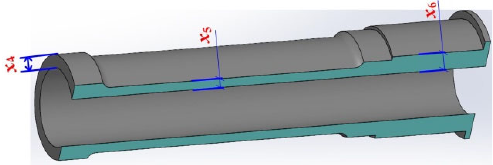
Figure 12. Geometrical structure of the small arm.